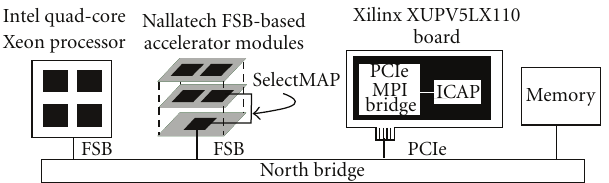
Figure 7: Development platform with FSB and PCIe-based FPGA boards.